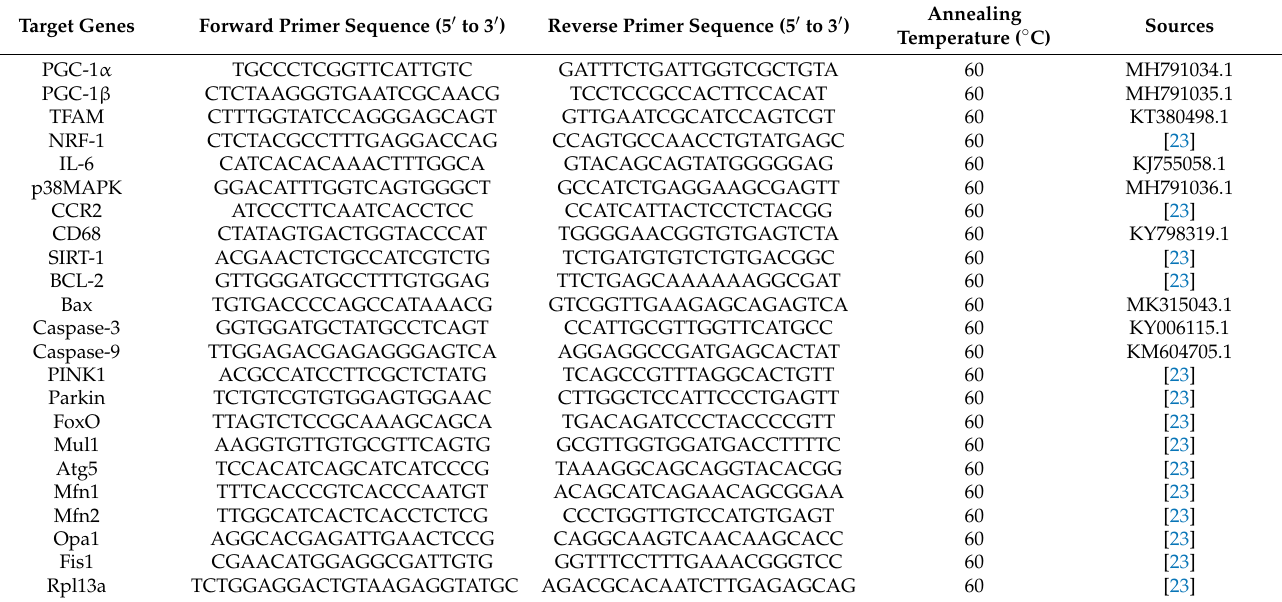
Table 2. Sequences of primers used for RT-PCR in this study. Target